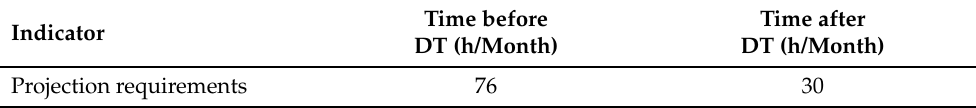
Table 3. Time comparison for offer